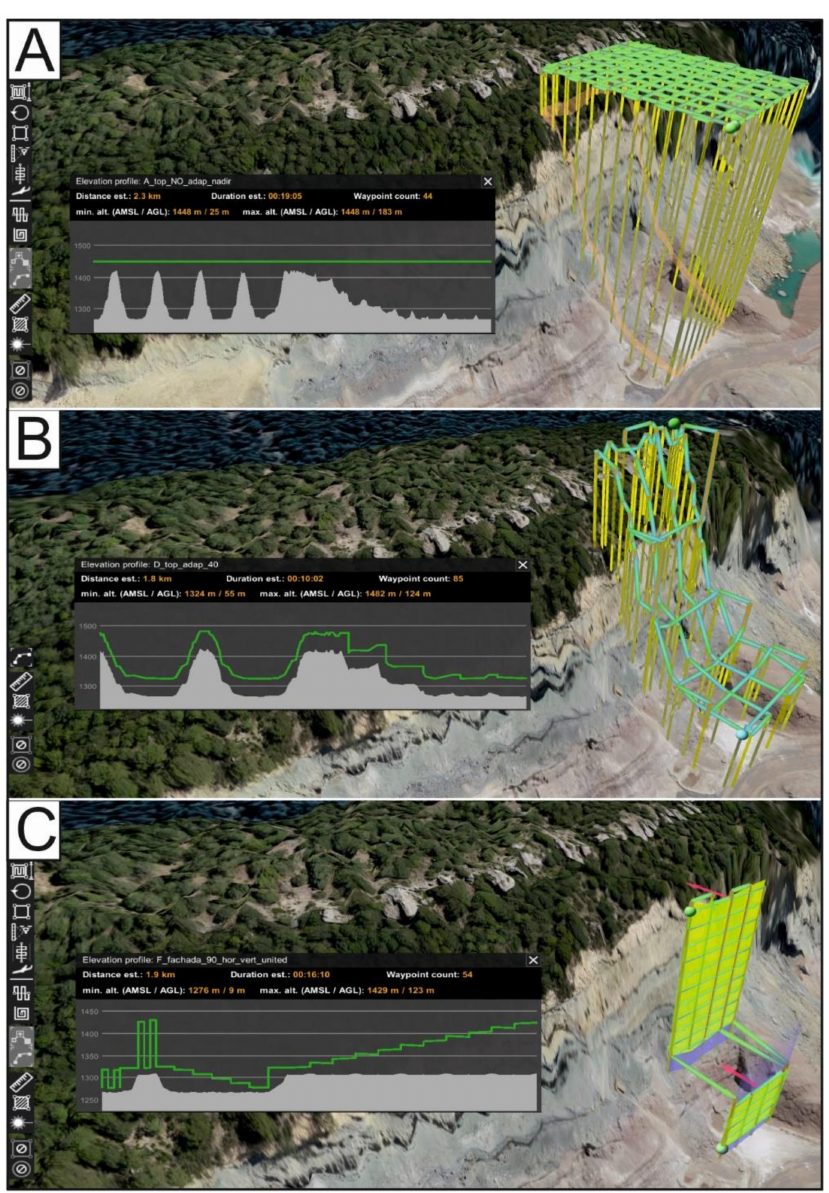
Figure 3. View of the flight missions and profiles programmed with the computer-based mission planning software UgCS: Above mean sea level, nadir and 40 ◦ off-nadir angles ( A ); Above ground level, nadir, 40 ◦ off-nadir and Point of Interest angles ( B ); and facade, nadir and 40 ◦ off-nadir angles ( C